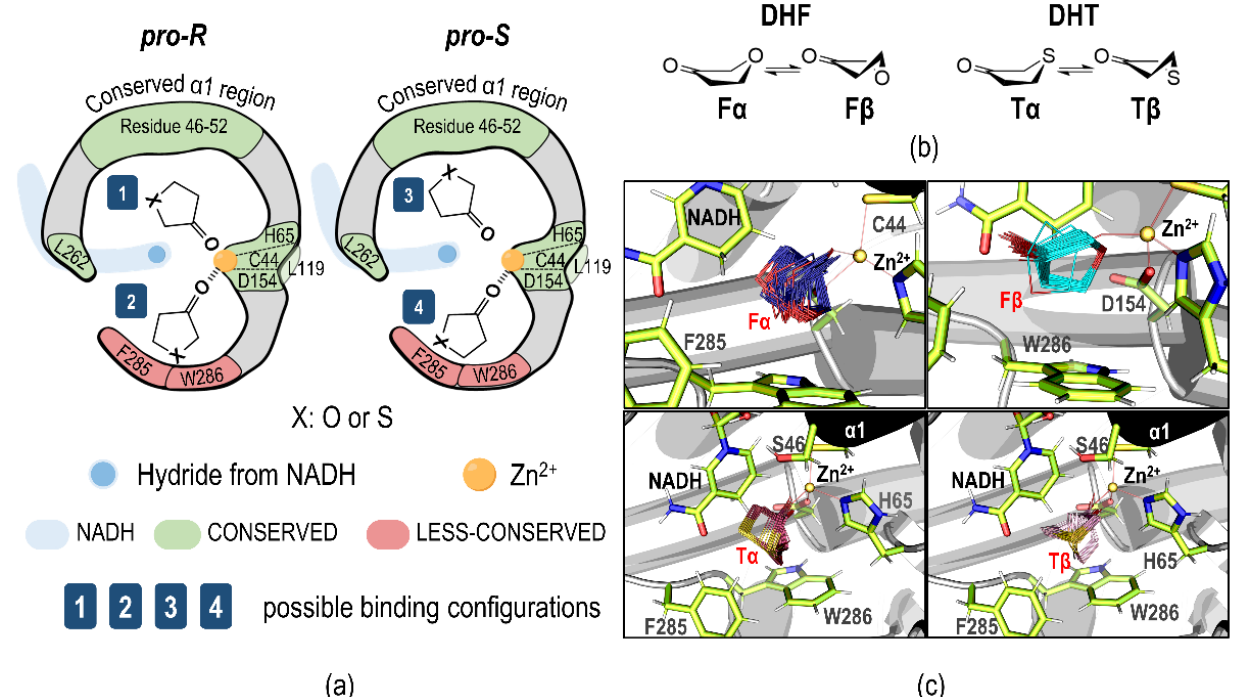
Figure 2. Molecular dockings of the heterocyclic ketones in Cp RCR ( a )Four plausible orientations of the 5-m-r heterocyclic ketones in the large and small cavities of Cp RCR. The highly conserved region of the large cavity and catalytic triad were colored in green, and the less-conserved small cavities comprising of F285-W286 were colored in brown. ( b ) half-chair conformers (the two mirror structures labeled as α and β ) for two substrate ligands ( DHF and DHT ) in molecular docking, i.e., F α , F β , T α , and T β . ( c ) Diagram of the molecular docking results of the DHF and DHT substrates inside Cp RCR. The superpositions of docking poses, using 50 poses only as representative which constitute both pro-R and pro-S conformations.